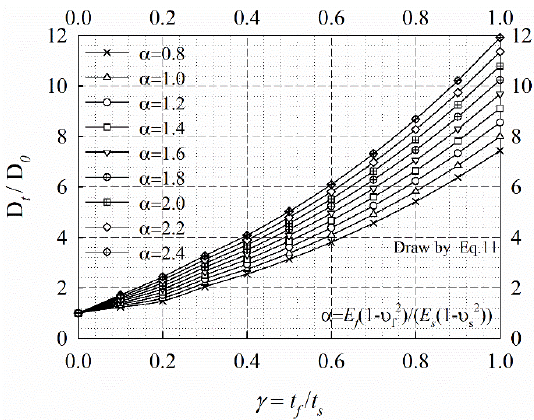
Figure 5. Variation of Stiffness enhancing ratio D t / D 0 calculated by Equation (11) as a function of γ .